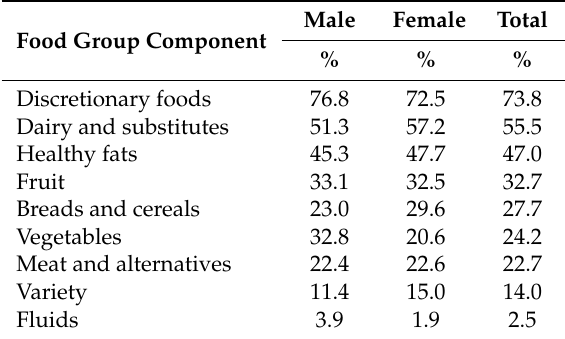
Table 3. Frequency of User Feedback by Food Group and Gender ( n =